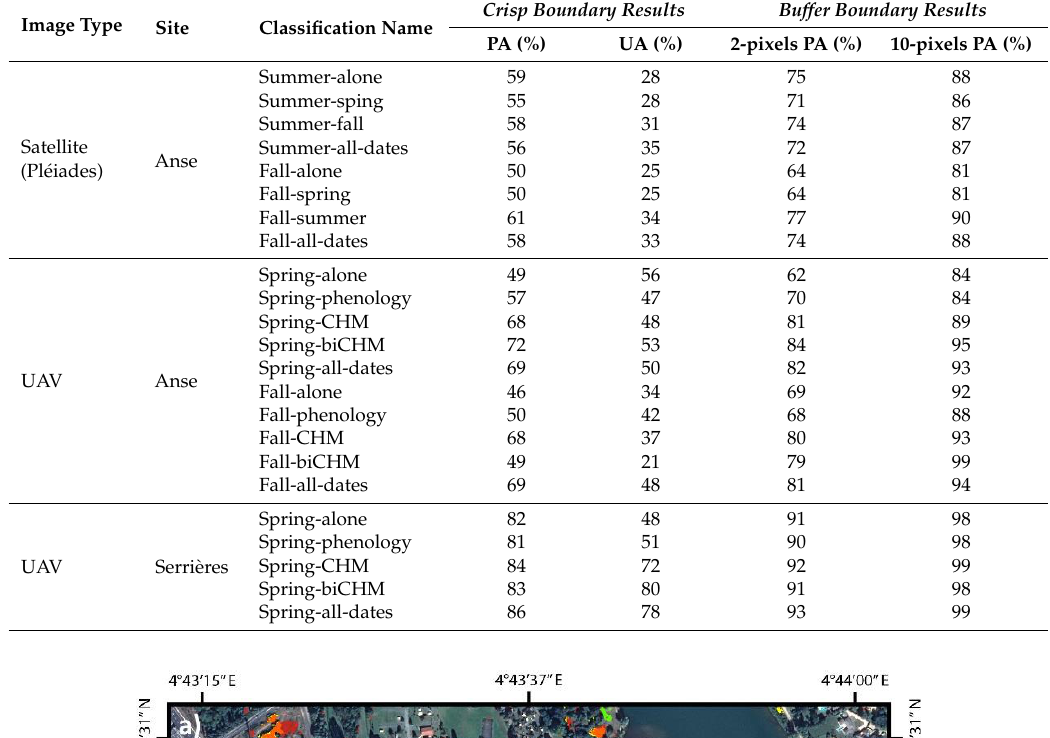
Table 3. Classification accuracy assessments for both sites and image types. ‘PA’, Producer Accuracy; ‘UA’, User Accuracy. For details on the characteristics of each classification, see Table 2.